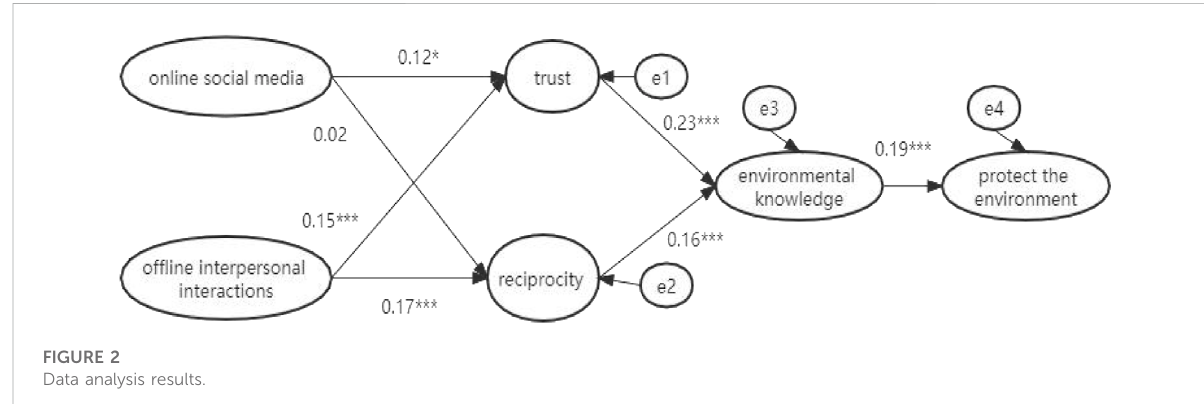
FIGURE 2 Data analysis